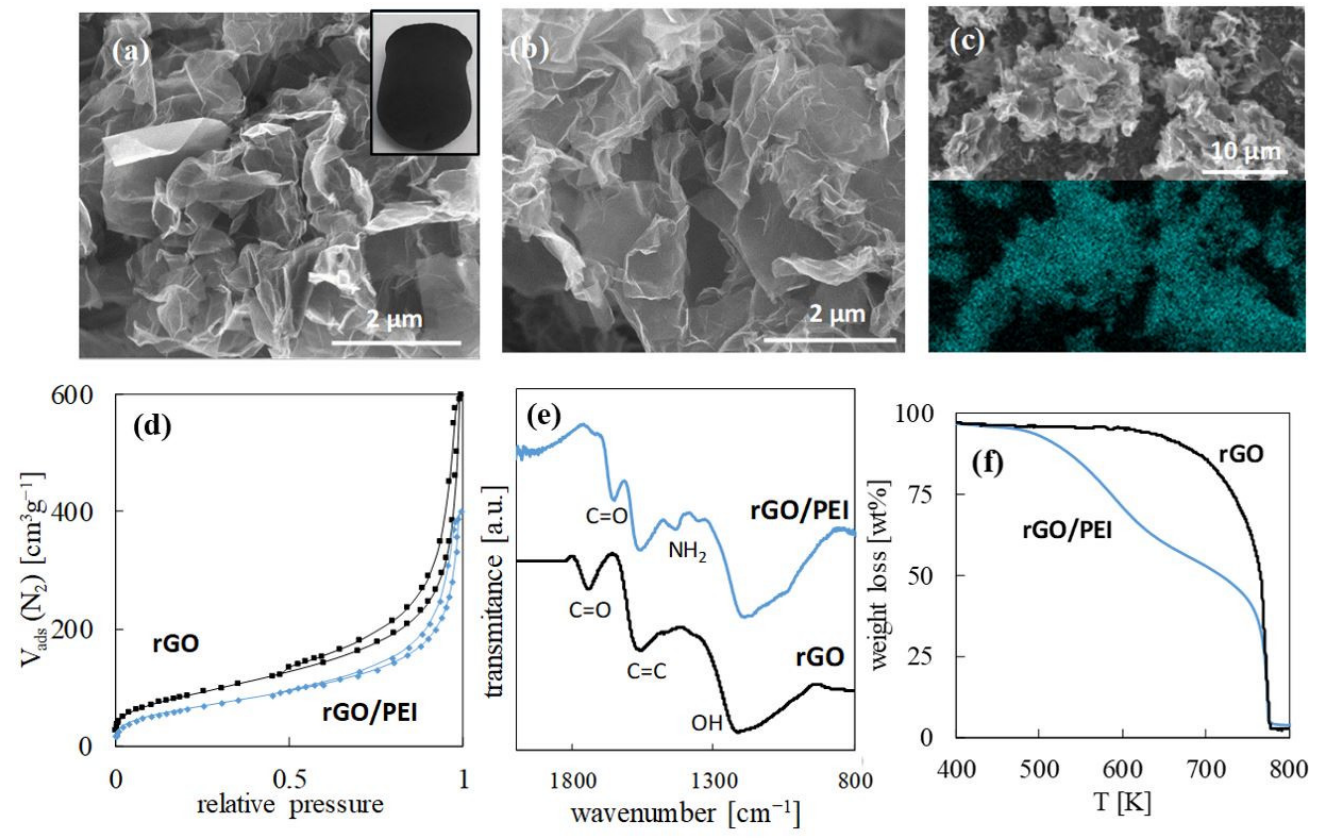
Figure 1. The characterization of the rGO and rGO/PEI sorbents: SEM of ( a ) rGO (the insight is an aerogel monolith) and ( b ) rGO/PEI; ( c ) EDS mapping of N 2 for the rGO/PEI; ( d ) N 2 adsorption/desorption isotherms; ( e ) FTIR-ATR spectra; and ( f ) TGA.